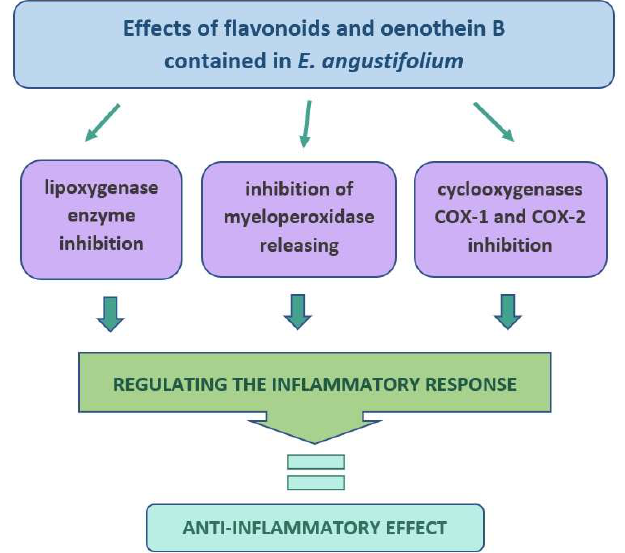
Figure 5. A diagram showing schematically the mechanism of the anti-inflammatory effect of the ingredients contained in E. angustifolium